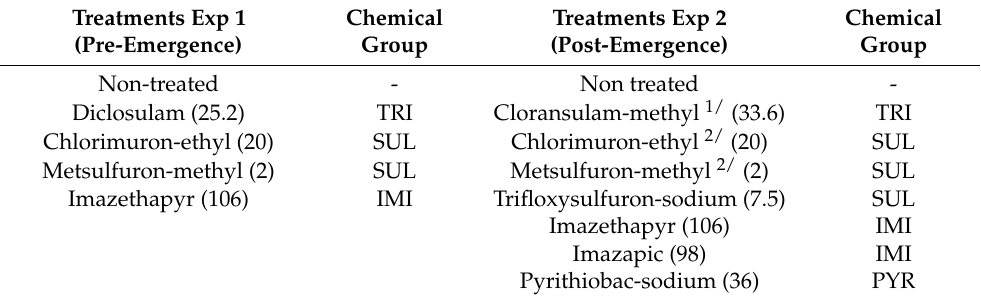
Table 4. Herbicides, label doses used in Brazil (g a.i. or a.e. ha − 1 ), and application modality for cross-resistance